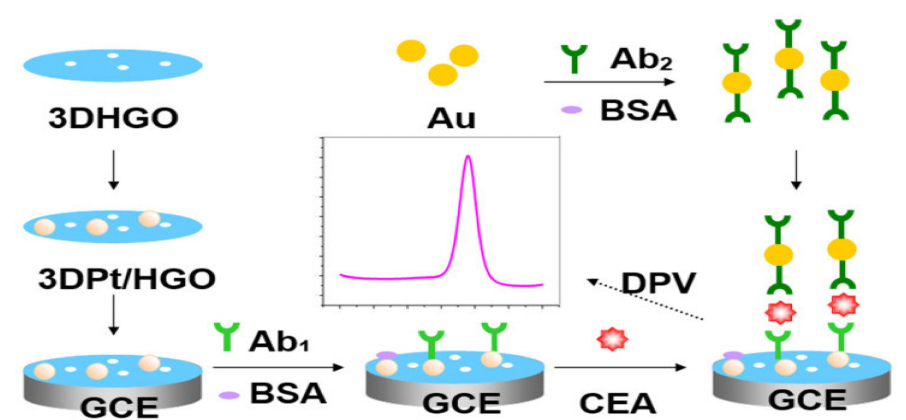
Figure 14. Illustrative fabrication process of carcinoembryonic antigen (CEA) sandwich immunosen- sor. Ab 1 : capture antibody; Ab 2 : secondary antibody; 3DPt/HGO: 3D porous graphene–oxide– supported platinum metal nanoparticles; GCE: glass carbon electrode [113].